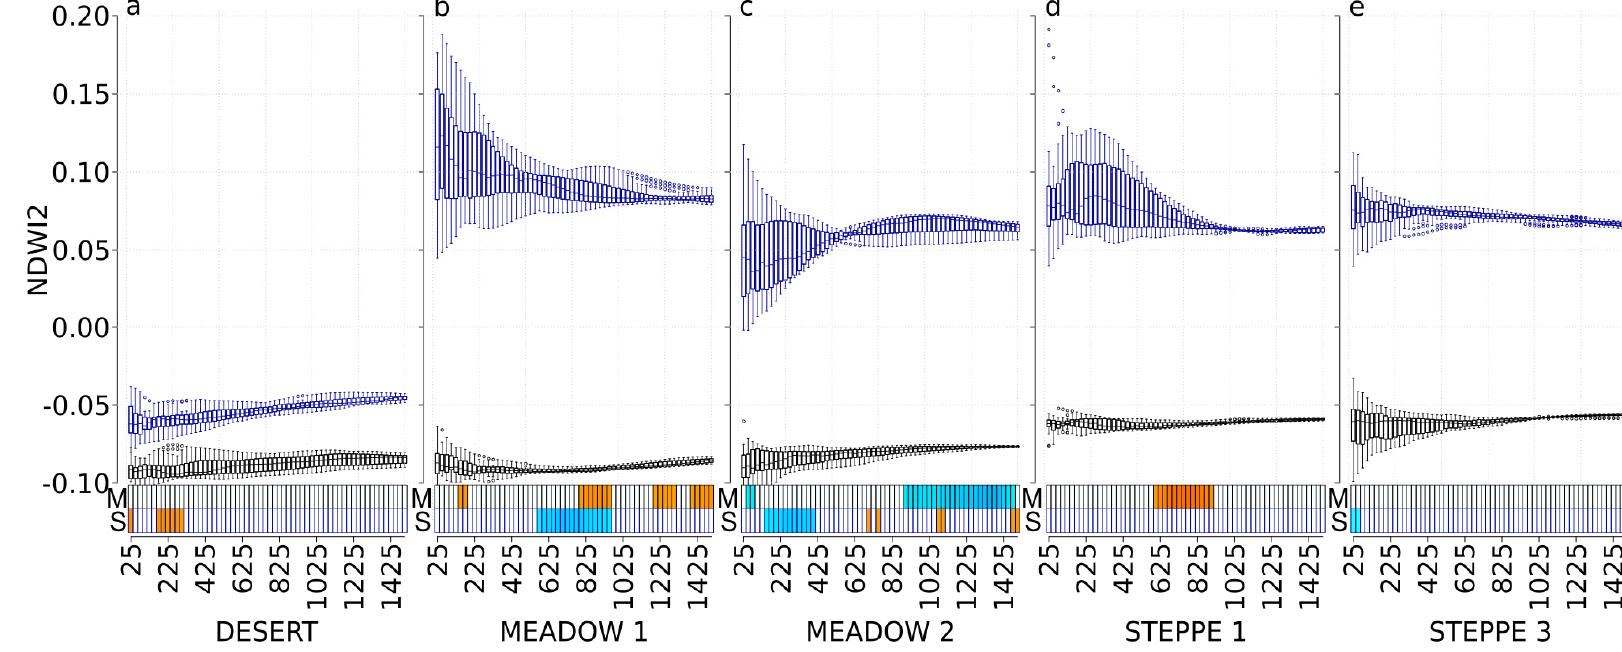
Figure 5. NDWI2 values at each scale and correlations with carabid abundances for the desert steppe (a), the meadow steppe 1 and 2 (b and c, respectively), and the typical steppe 1 and 3 (d and e, respectively). Boxplots represent the NDWI2 values with a black border for the May 2017 Landsat image (M) and with a dark-blue border for the September 2017 Landsat image (S). For each boxplot, a different background color indicates a significant difference in NDWI2 values using the Tukey test. The x -axis presents the different spatial scales used in the analysis (cardinal distances in meters representing circle radius ranging from 25 to 1500 m). The correlation with carabid abundances is represented with rectangles at the bottom of each graph, using a gradient from blue to red (dark blue corresponds to a negative correlation, dark red corresponds to a positive correlation, and white corresponds to no significant correlation).